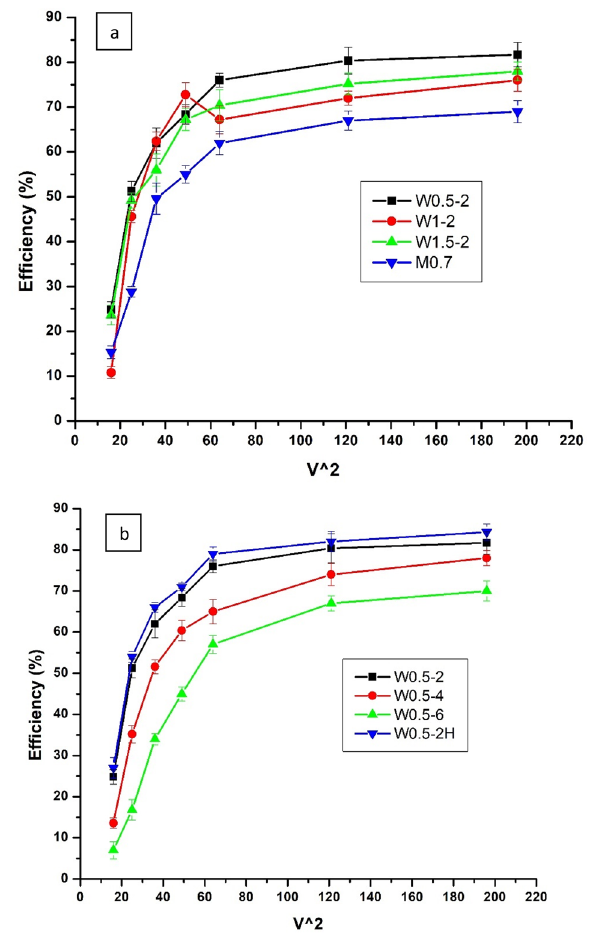
Fig. 7 Fog harvesting efficiency in the presence of electric field for different wire